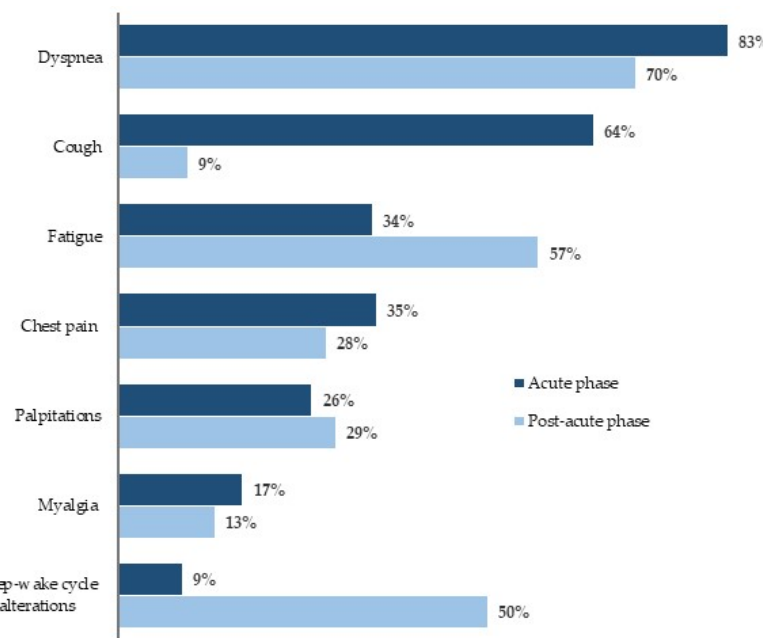
Figure 1. COVID-19-Related symptoms.